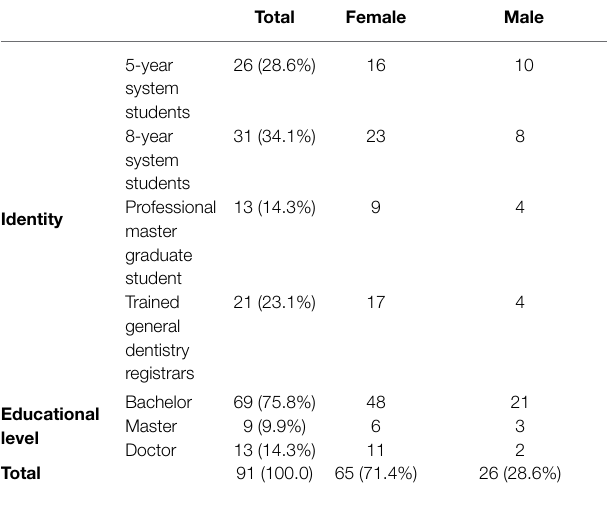
TABLE 1 | Demographic characteristics of the